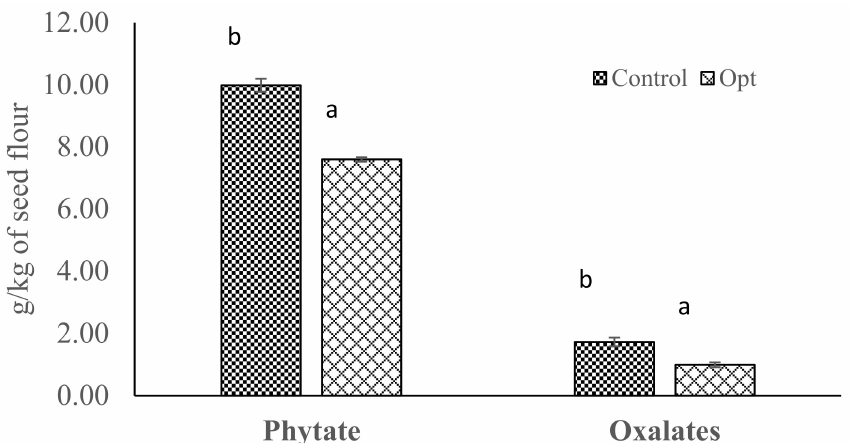
Figure 3. Phytate and oxalates content of cowpeas processed at optimized conditions. Error bars indicate standard deviation (N = 3). Bars with different alphabets indicate significant difference ( p ≤ 0.05).